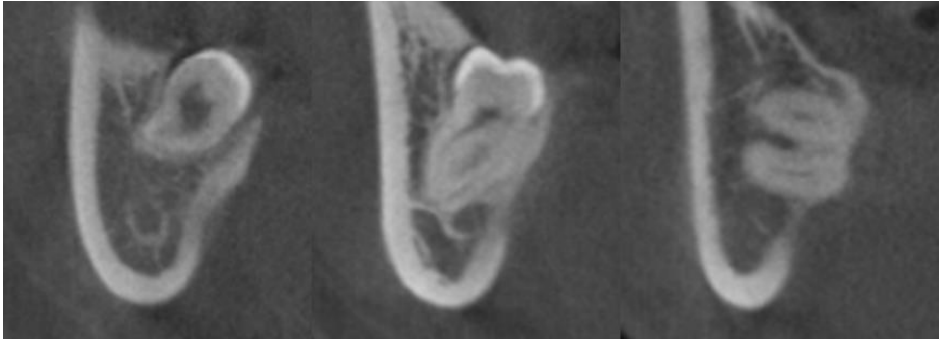
Figure 3. Classification of the relationship of the mandibular third molar to the lingual cortex by Ohman et al. [13]: no contact (left); contact, thinning (middle); contact, perforation (right).